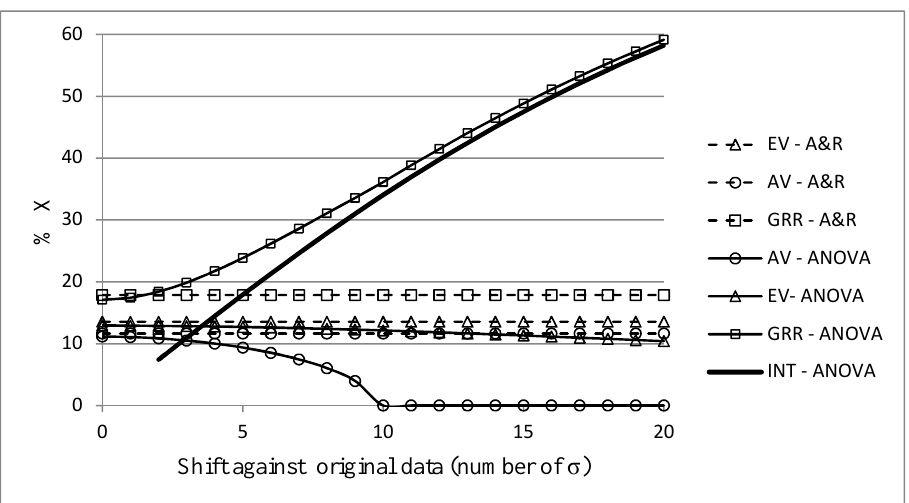
Figure 2 Changes in GRR study for Simulation